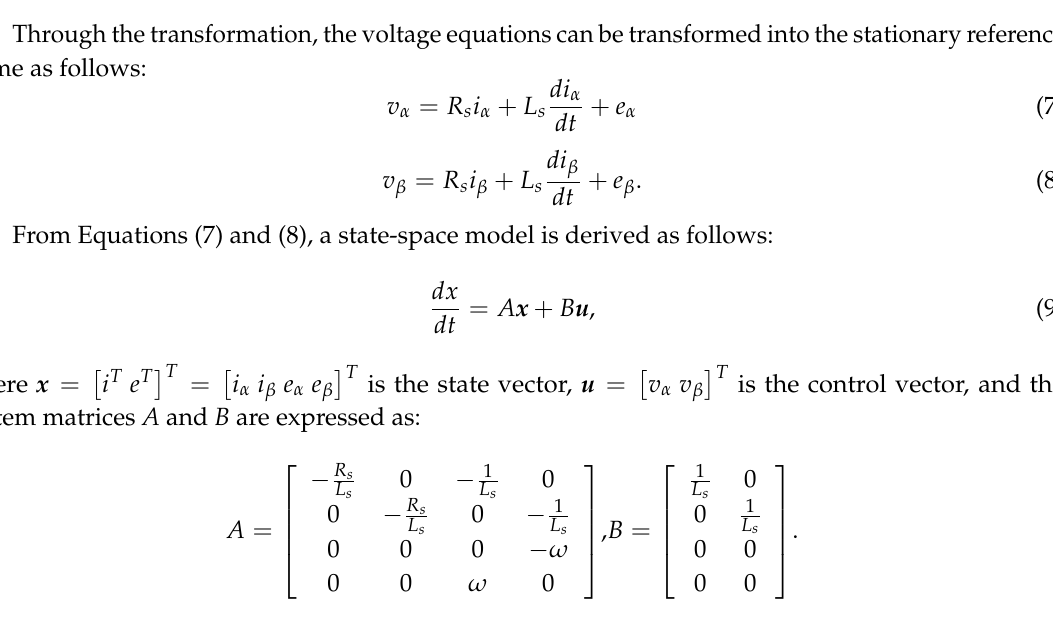
Figure 1. Block diagram of a three-phase grid-connected inverter.